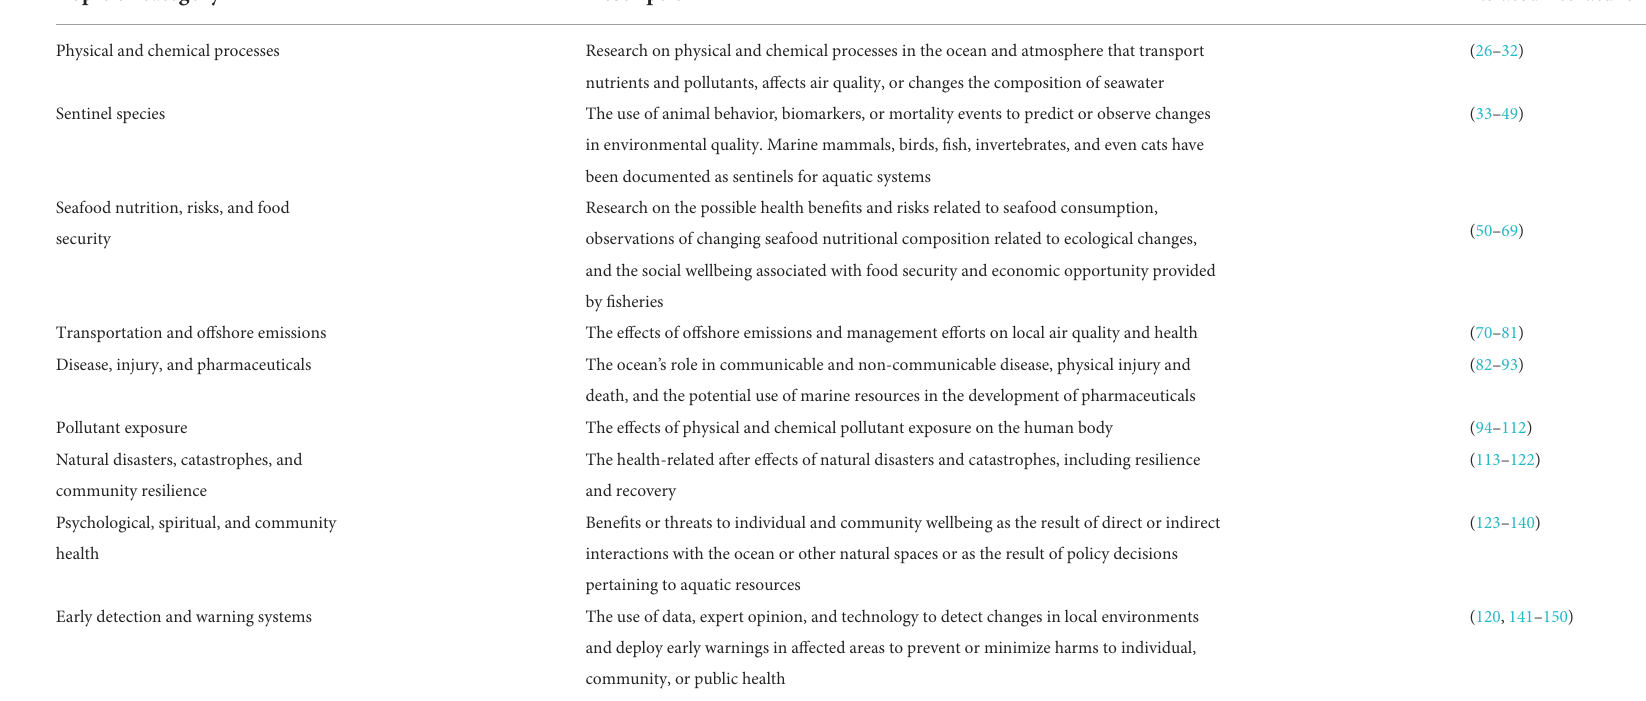
TABLE 1 Examples of topics in OHH science and relevant